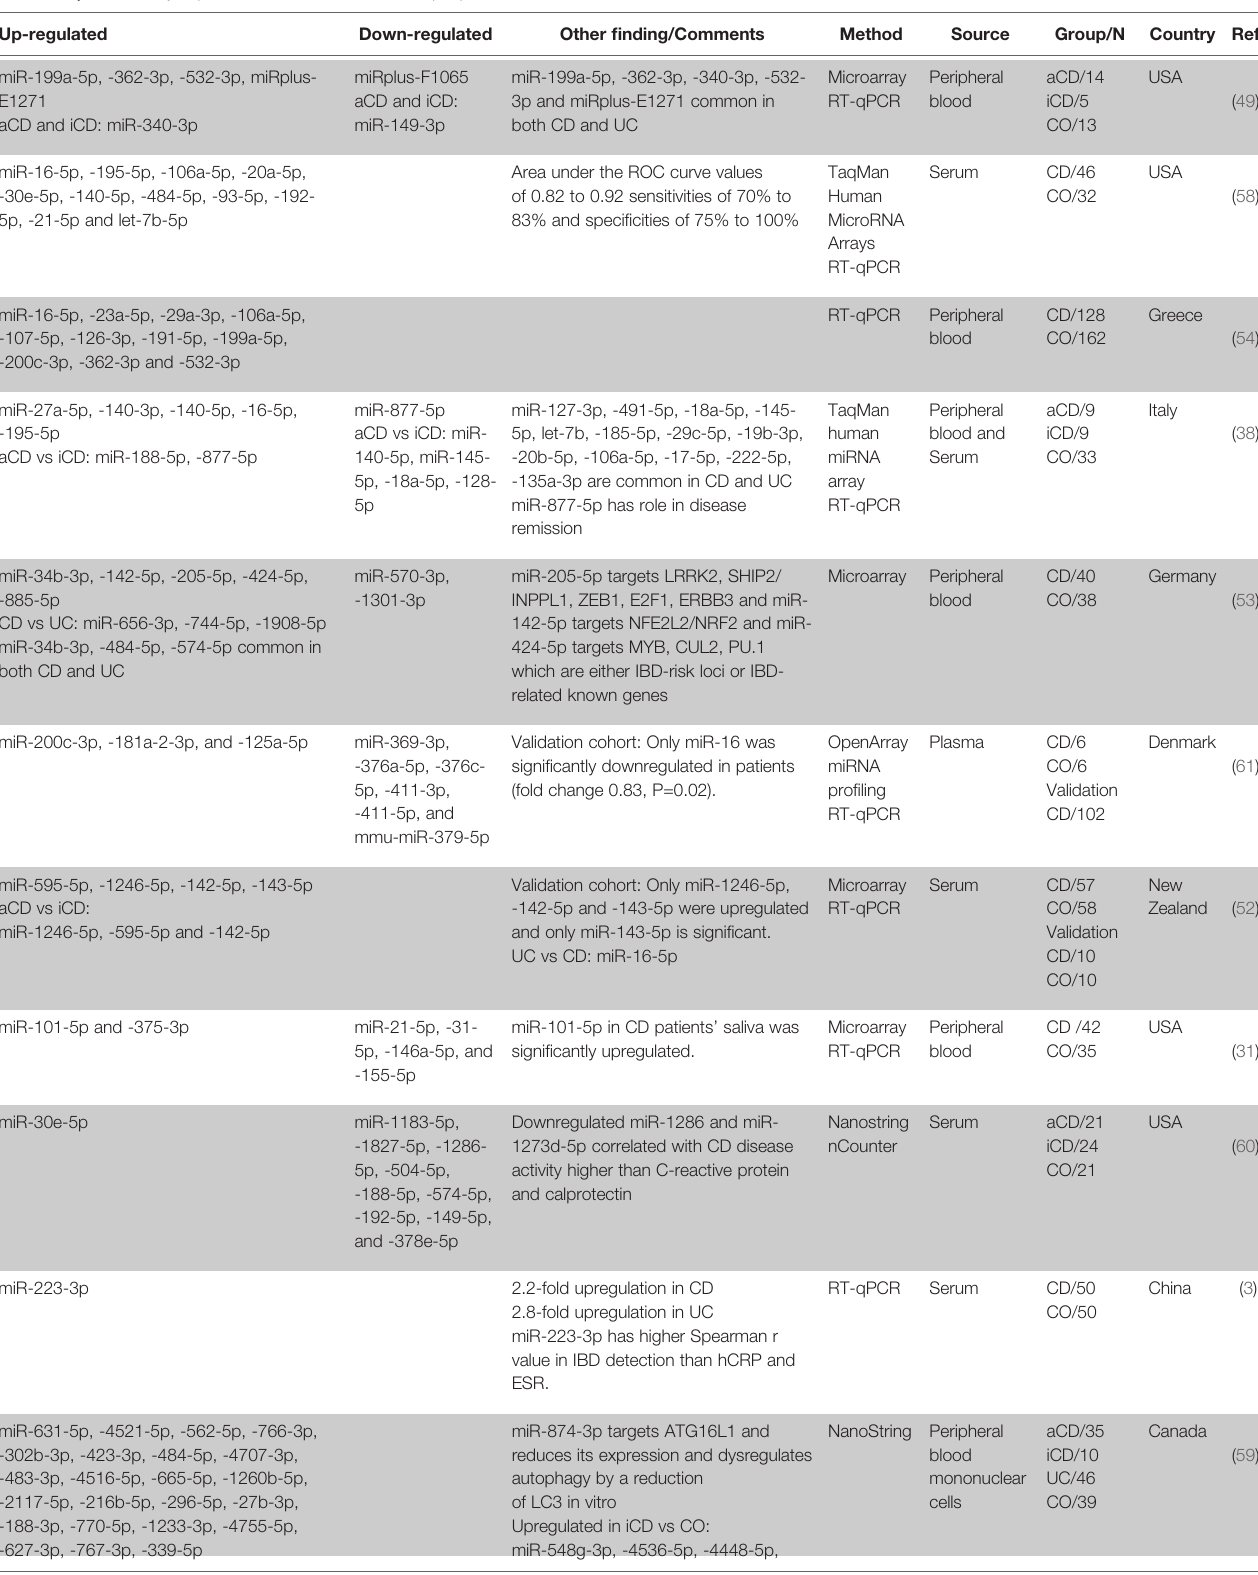
TABLE 4 | Differentially expressed miRNAs in human CD peripheral blood based on literature